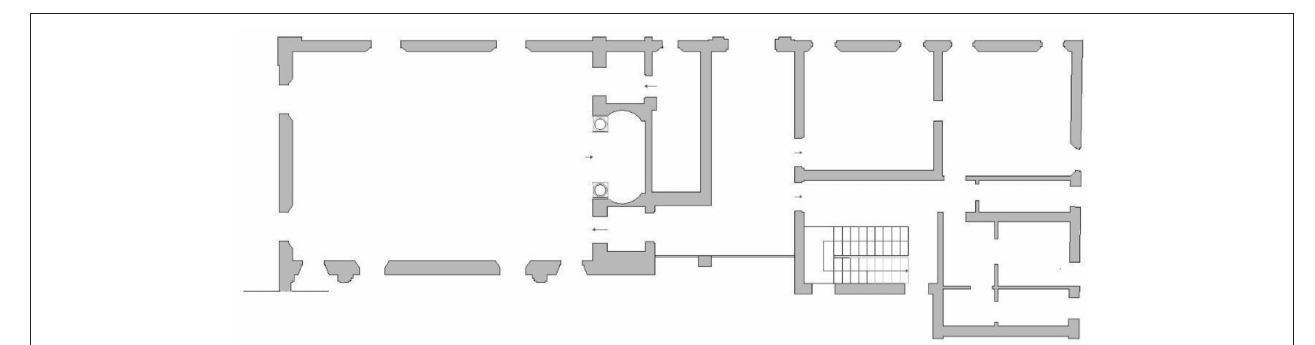
FIGURE 4 | Structural Part B of the